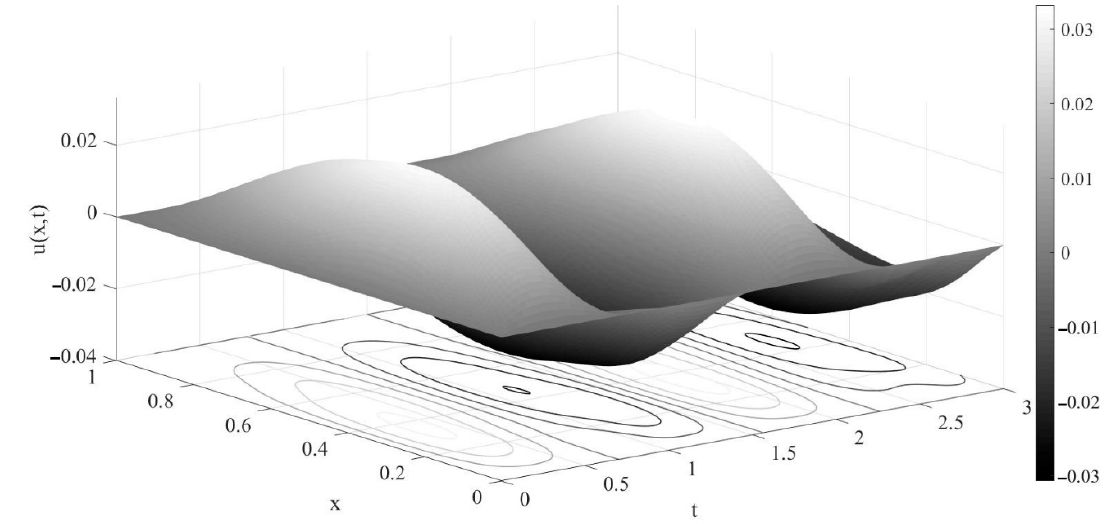
Figure 2. The graph of the approximate solution u ( 7 ) ( x , t ) of problems (1)–(4) under the imposed conditions in Example 1.